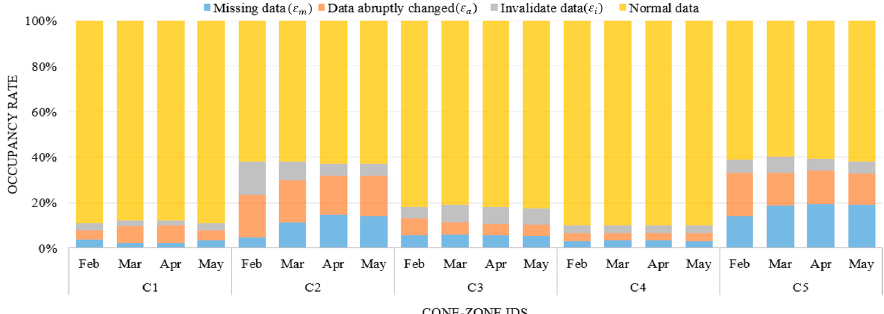
Figure 8. Data distribution of noise during four months at the respective cone zones.